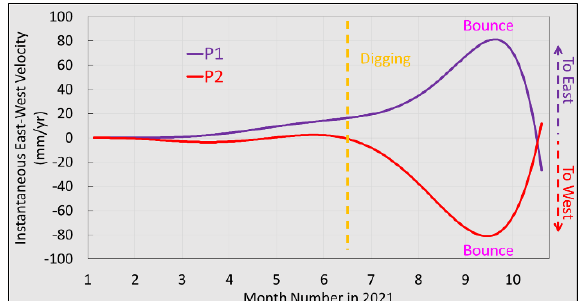
Figure 17. Series of instataneous vertical velocity of P1 and P2 (Figure 15). Mining occurred in middle